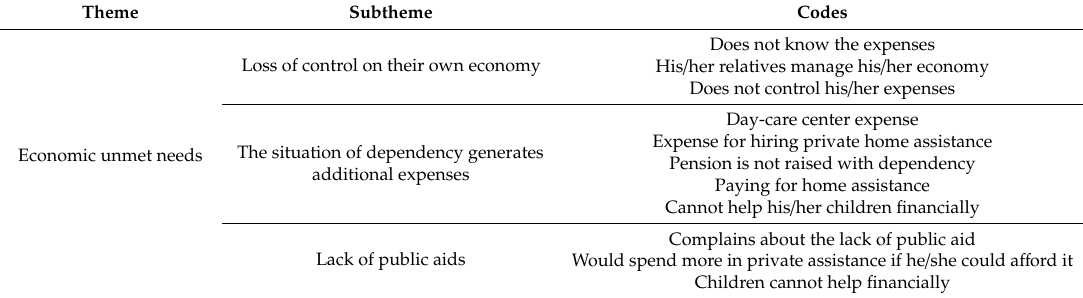
Table 5. Theme, subthemes, and codes related to the satisfaction of social needs of PCDD.